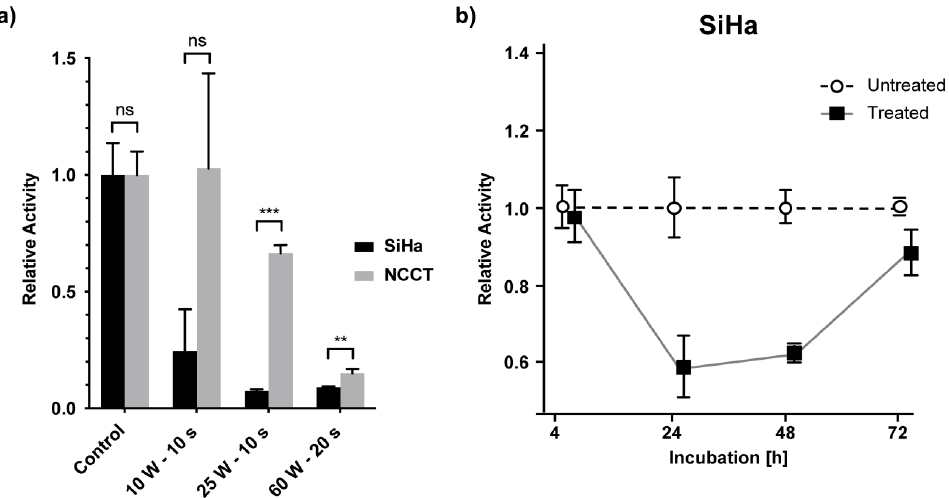
Figure 3. Metabolic activity was decreased in SiHa cells compared to NCCT cells. ( a ) Relative metabolic activity measured via MTT assay in SiHa and NCCT cells 24 h after MABS treatment with given parameters. MABS treatment of SiHa and NCCT cells showed a different impact on metabolic activity. ( b ) Relative metabolic activity normalized to cell numbers of SiHa cells within 72 h after 10 W MABS treatment for 10 s. Metabolic activity was restored after an initial decrease. Results are expressed as the mean ± SD of relative activity. ** p < 0.01, *** p < 0.001 as determined by Student’s t ‐ test.